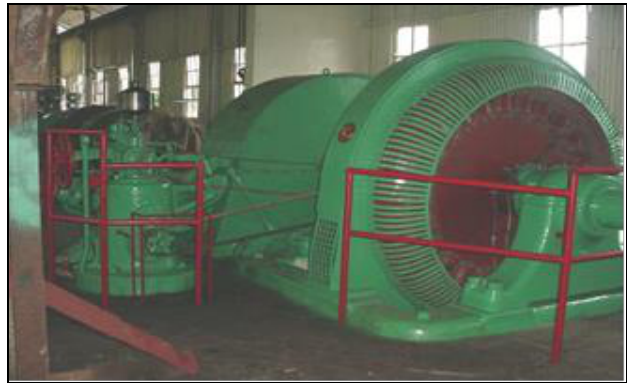
Figura 1: Sala de máquina de la PCH El Guaso (Guantánamo, Cuba). Fuente: Los autores,